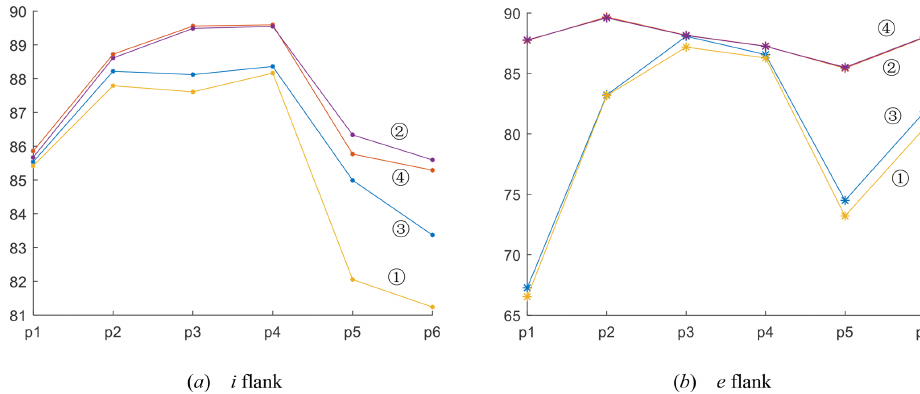
Figure 10. Numerical variation of the sliding angle at the observation